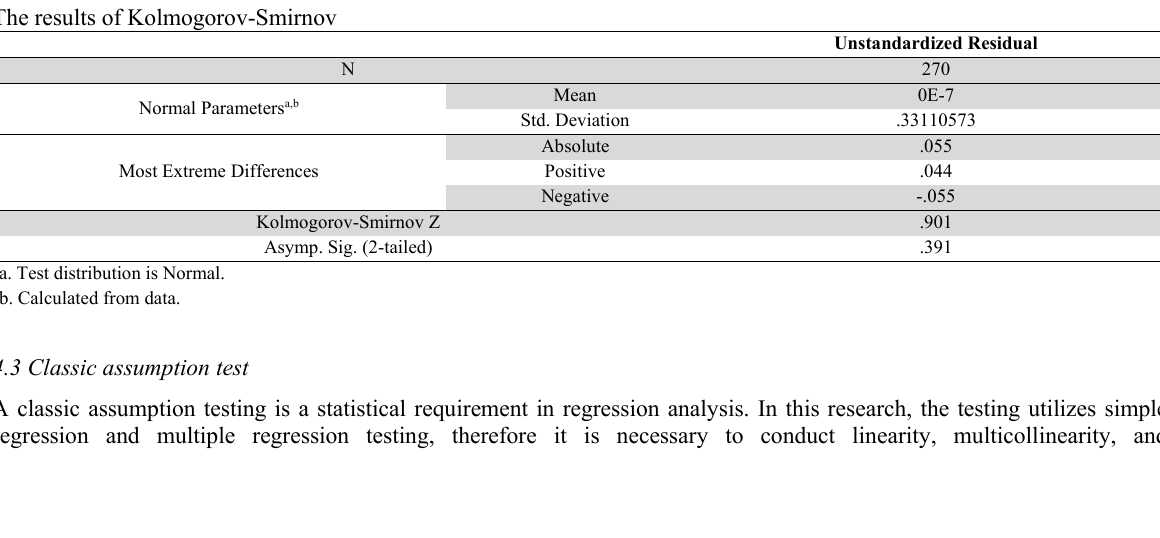
The results of Kolmogorov-Smirnov